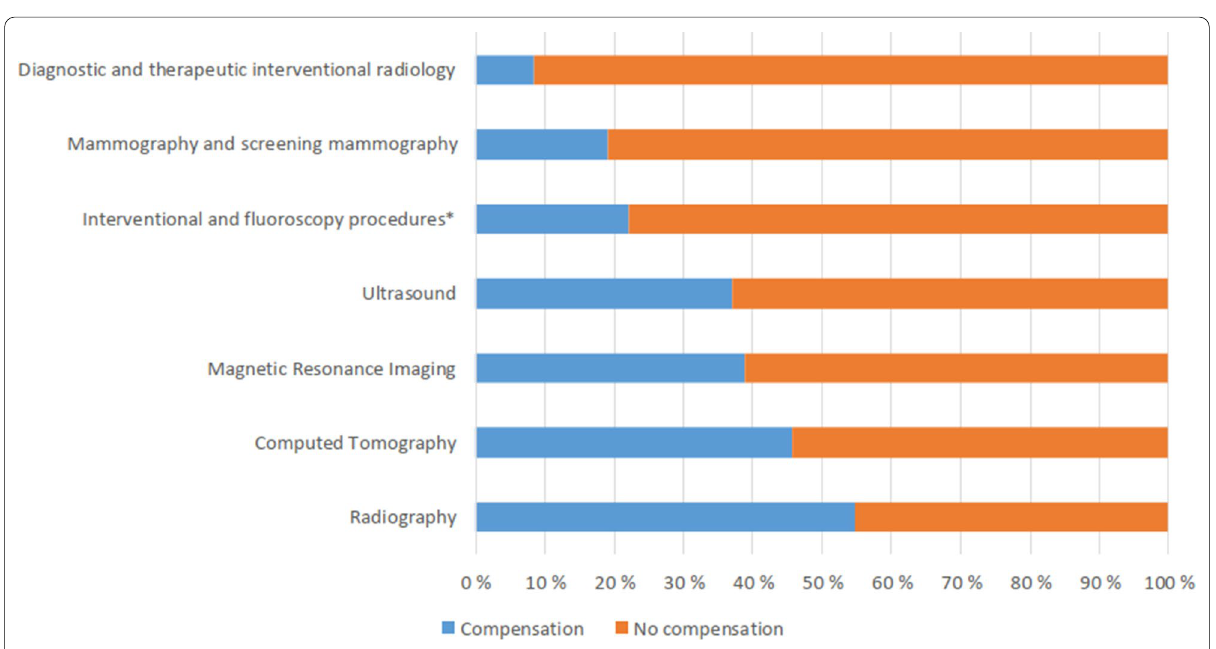
Fig. 4 Comparison of compensation payments related to different imaging